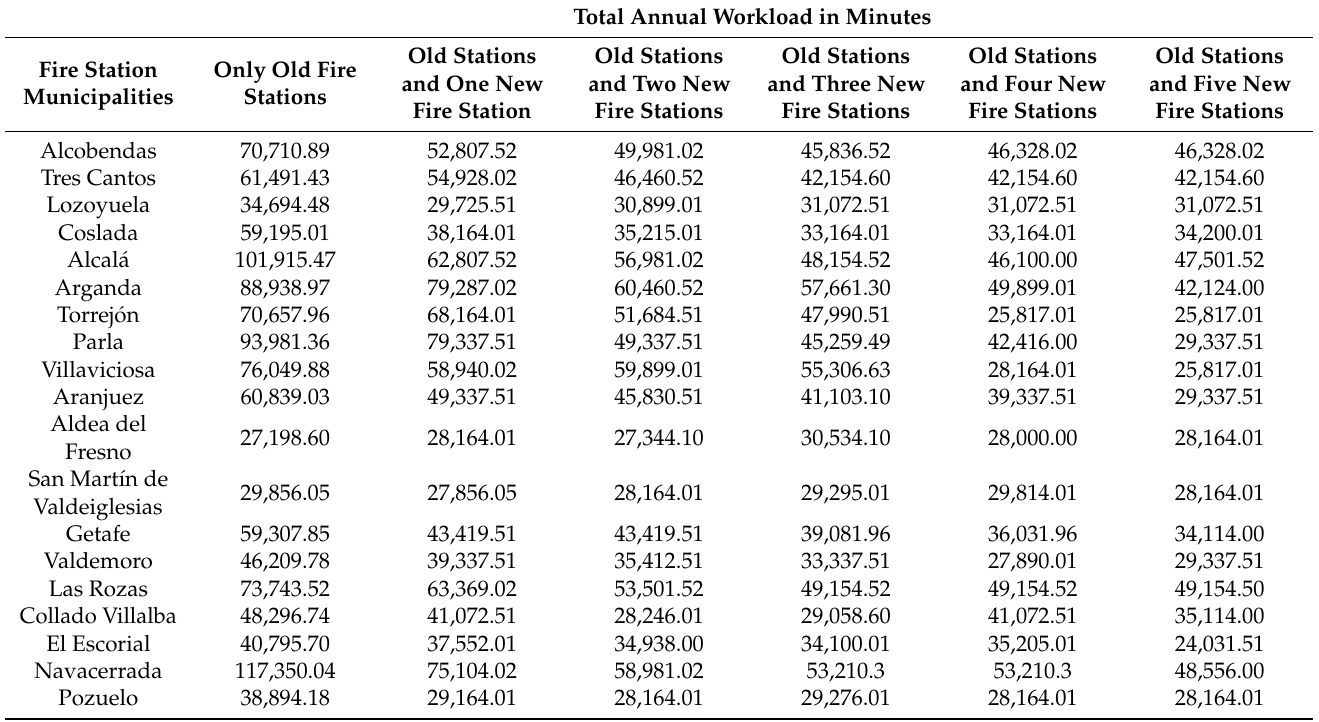
Table 3. Locations of old and new fire stations and workloads for each optimisation process. Total Annual Workload in